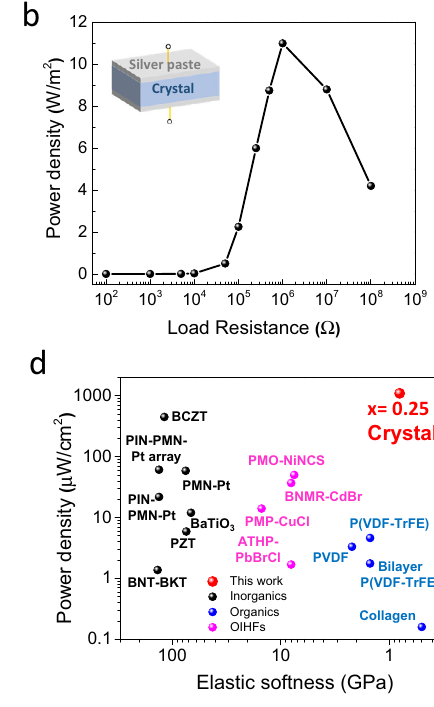
FOM among different piezoelectric materials. d Comparison of power density and material softness among different materials (see Supplementary Table 4 for references and